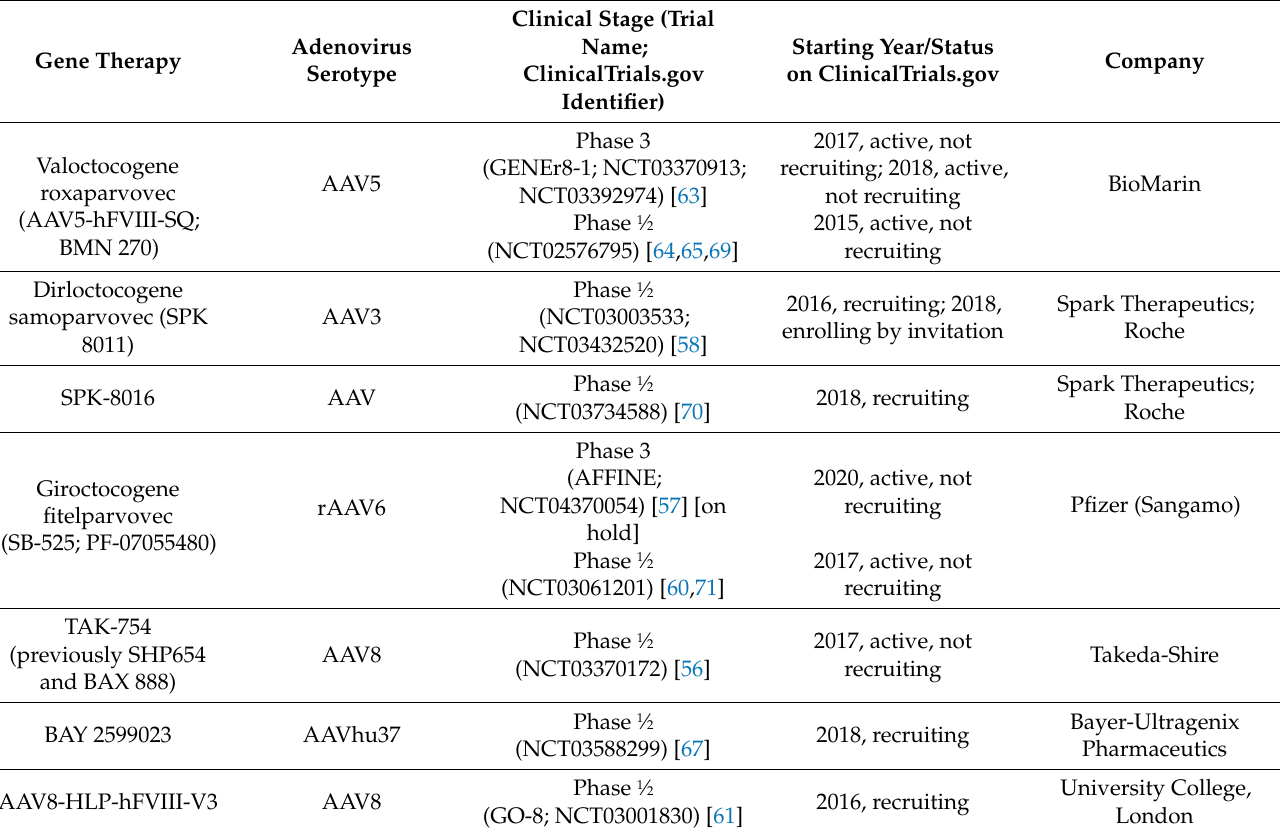
Table 1. Gene therapy trials involving adeno-associated viral (AAV) vectors in patients with hemophilia